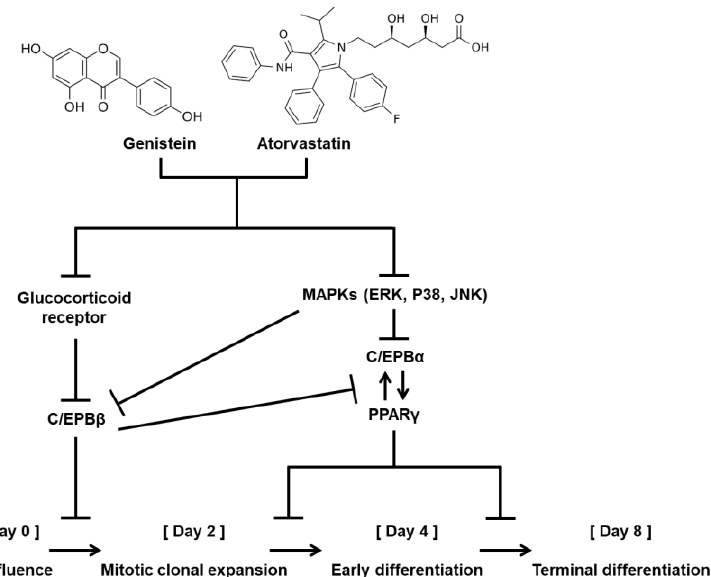
Figure 3. Schematic illustration of the underlying mechanism of the antiadipogenic effect of genistein and atorvastatin in 3T3-L1 preadipocytes.